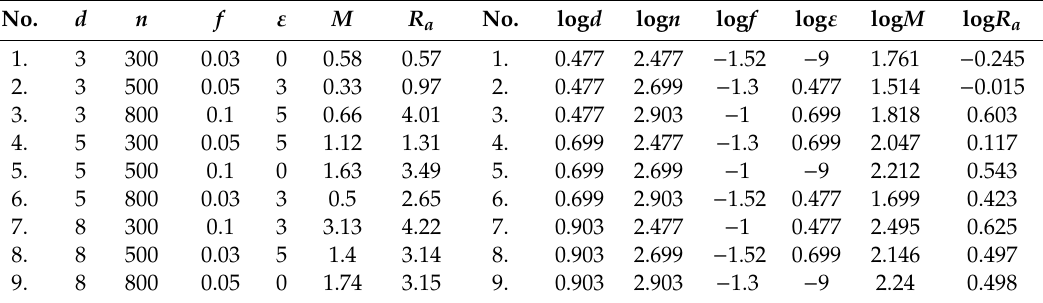
Table 10. Regression models formation data.